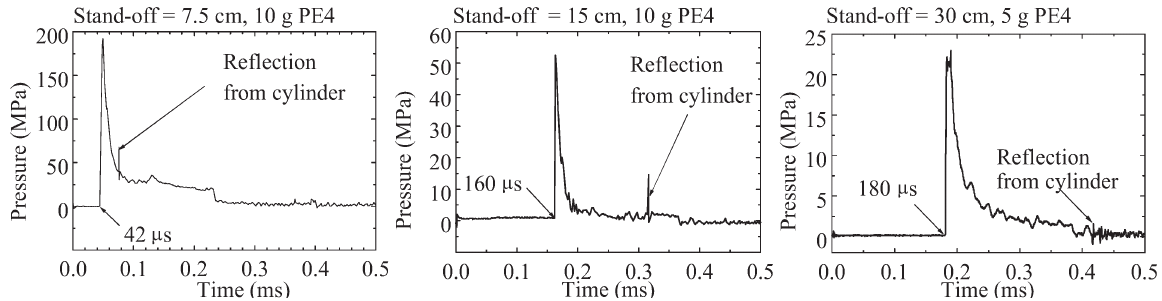
Fig. 8. Free field underwater pressure-time profiles at 7.5 and 15 cm stand-off distances for 10 g of PE4 explosive, and 30 cm for 5 g of PE4.